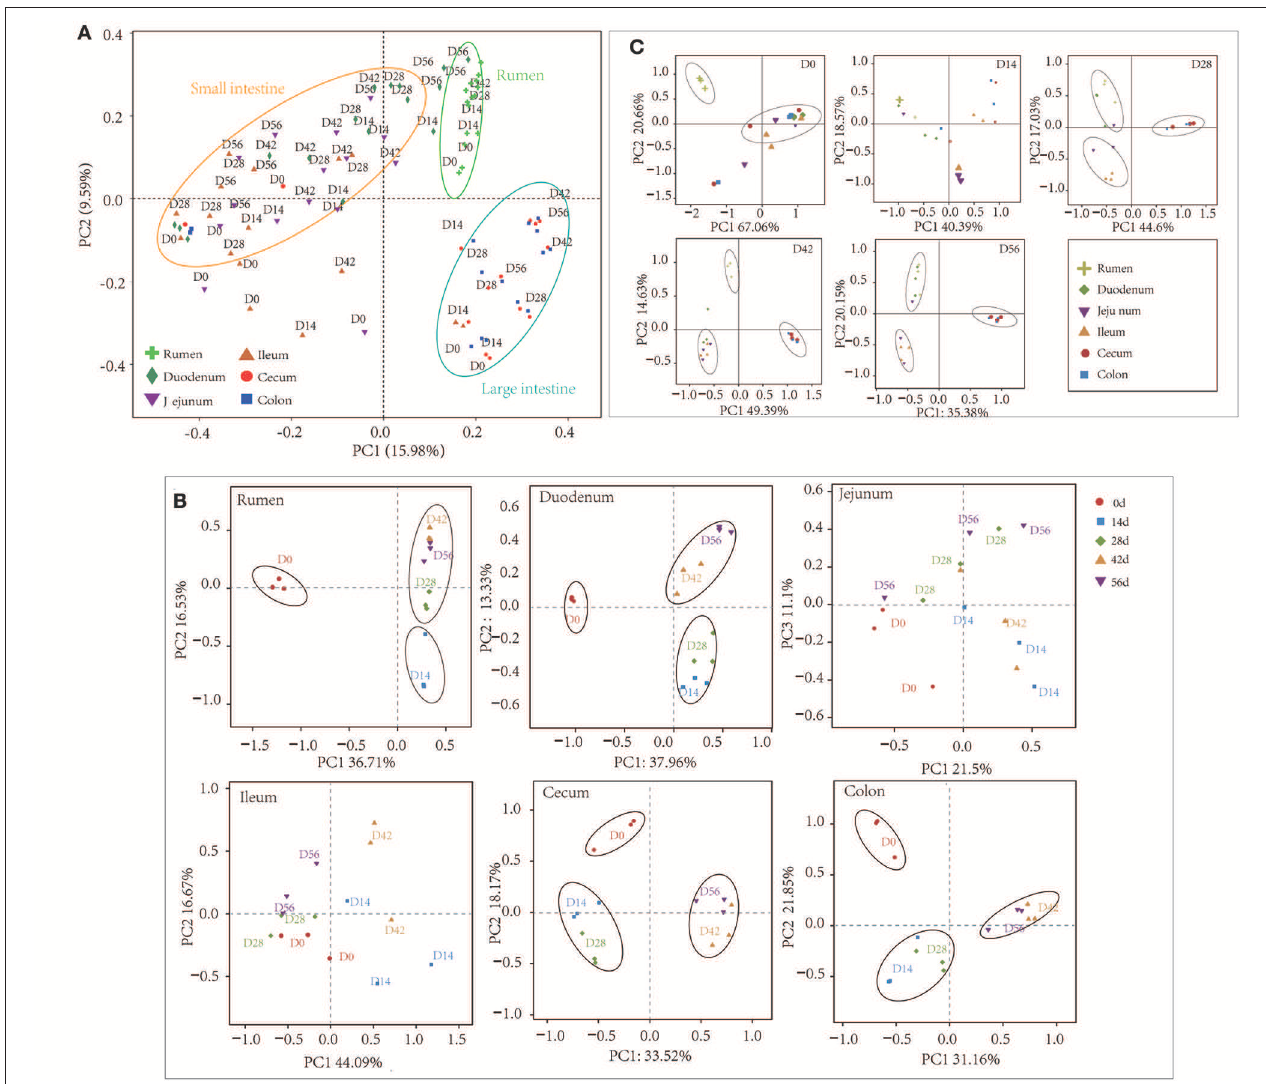
FIGURE 2 | Principal coordinate analysis (PCoA) profile of microbial diversity using the Bray-Curtis dissimilarity metric. The percentage of variation explained by PC1 and PC2 are indicated on the axis. (A) PCoA of bacterial microbiota across all samples. (B) PCoA of bacterial microbiota according to age group in each GIT region. (C) PCoA of bacterial community according to gastrointestinal tract (GIT) regions for each age